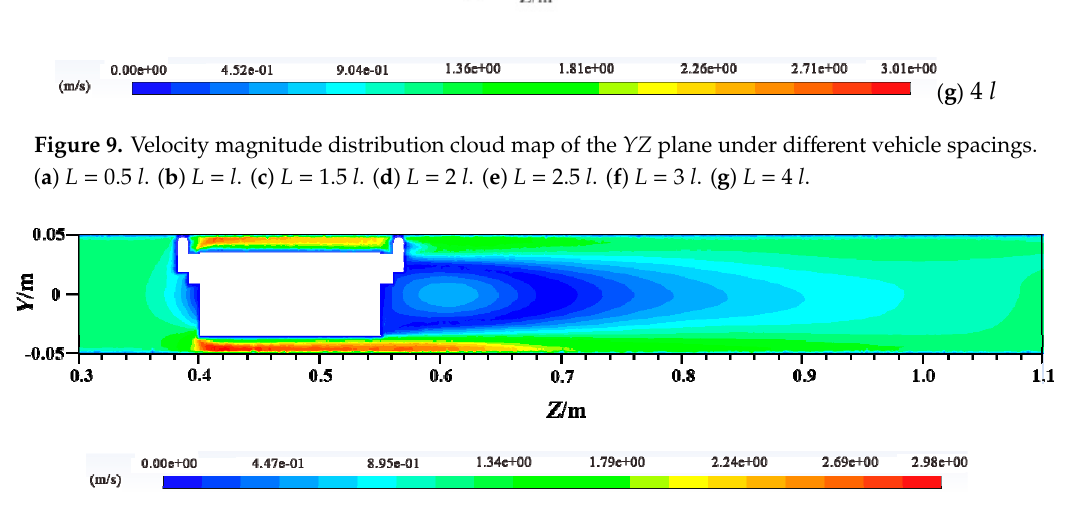
Figure 10. Velocity magnitude distribution cloud map of a single pipe vehicle in the YZ plane.